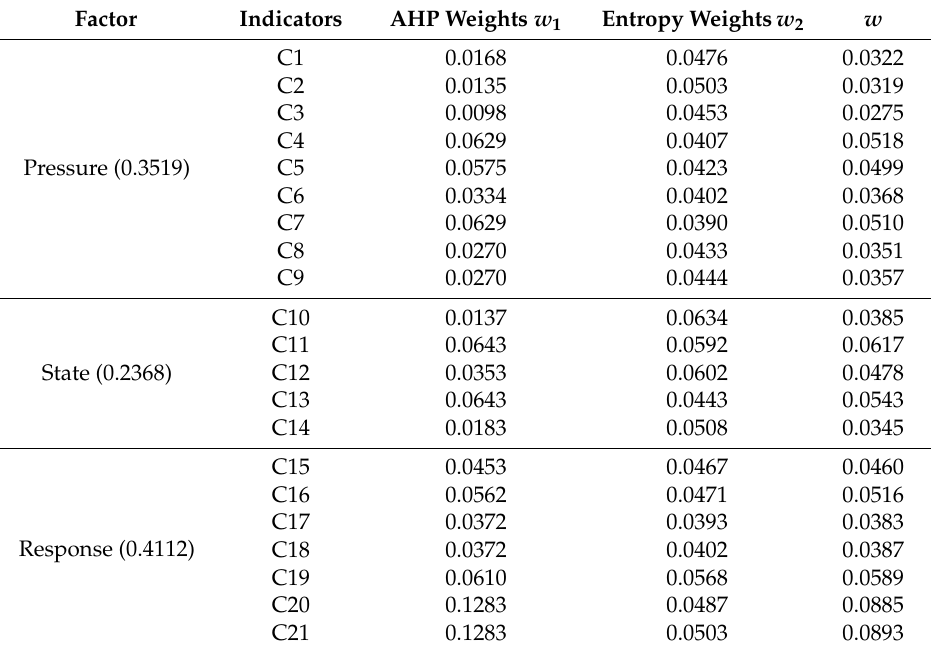
Table 3. The weights of evaluation indicators for water resource